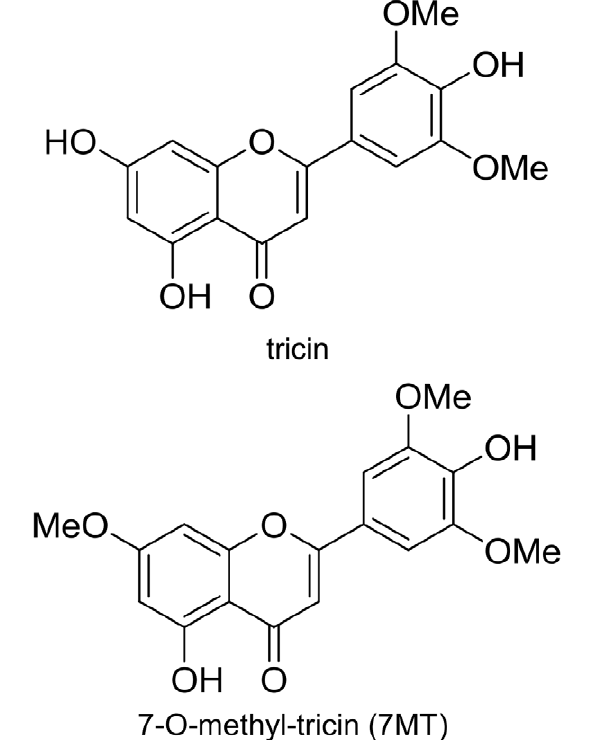
Figure 5. Molecular structures of tricin and 7-O-methyl-tricin (7 MT), two compounds isolated from BEX.